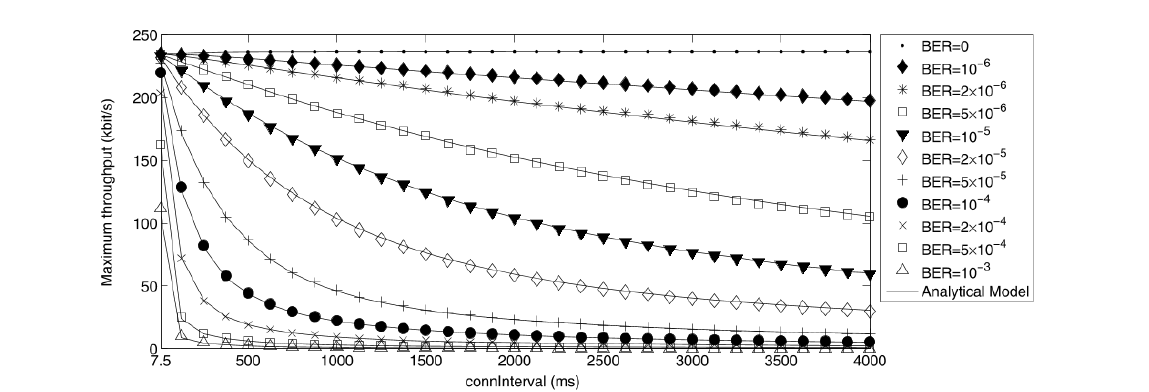
Figure 13. Maximum throughput of a Bluetooth Low Energy link for various connInterval (ranging between 7.5 ms and 4000 ms) and BER values (ranged from zero to 10 − 3 ): simulation (symbols) vs. analysis (lines). The simulation has been performed using 1,000,000 connEvents per each parameter set. Adapted from